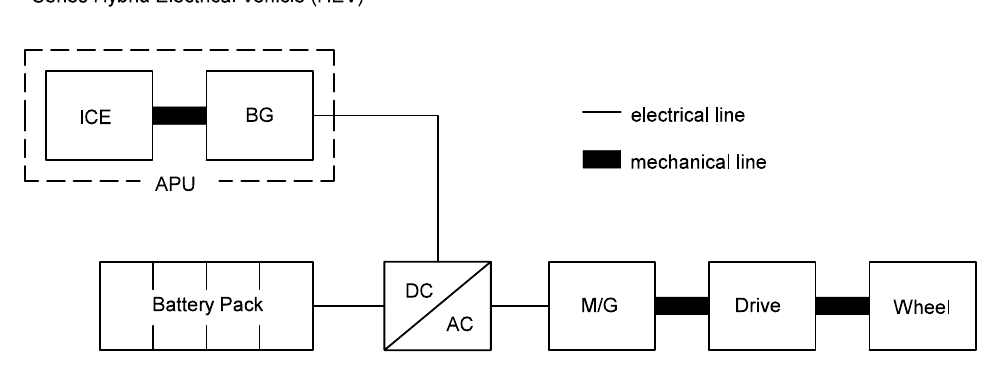
Figure 1. Schematic picture of the hybrid electric (HE)